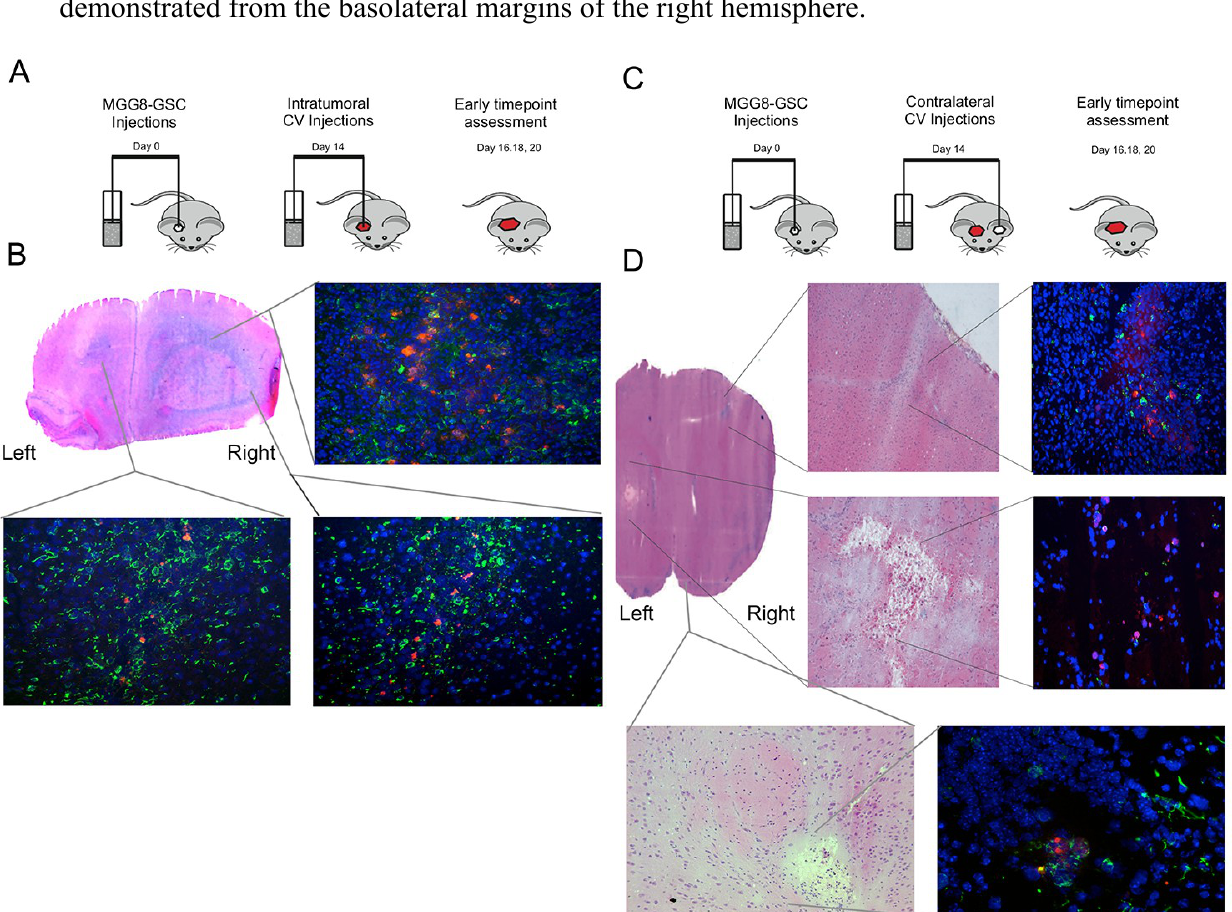
Figure 4. Intratumoral and contralateral Jurkat T-cell injections target GSC in vivo : ( A ) Schematic representation of the injection site and early time point assessment of cellular vehicle (CV)-Delta24-RGD distribution